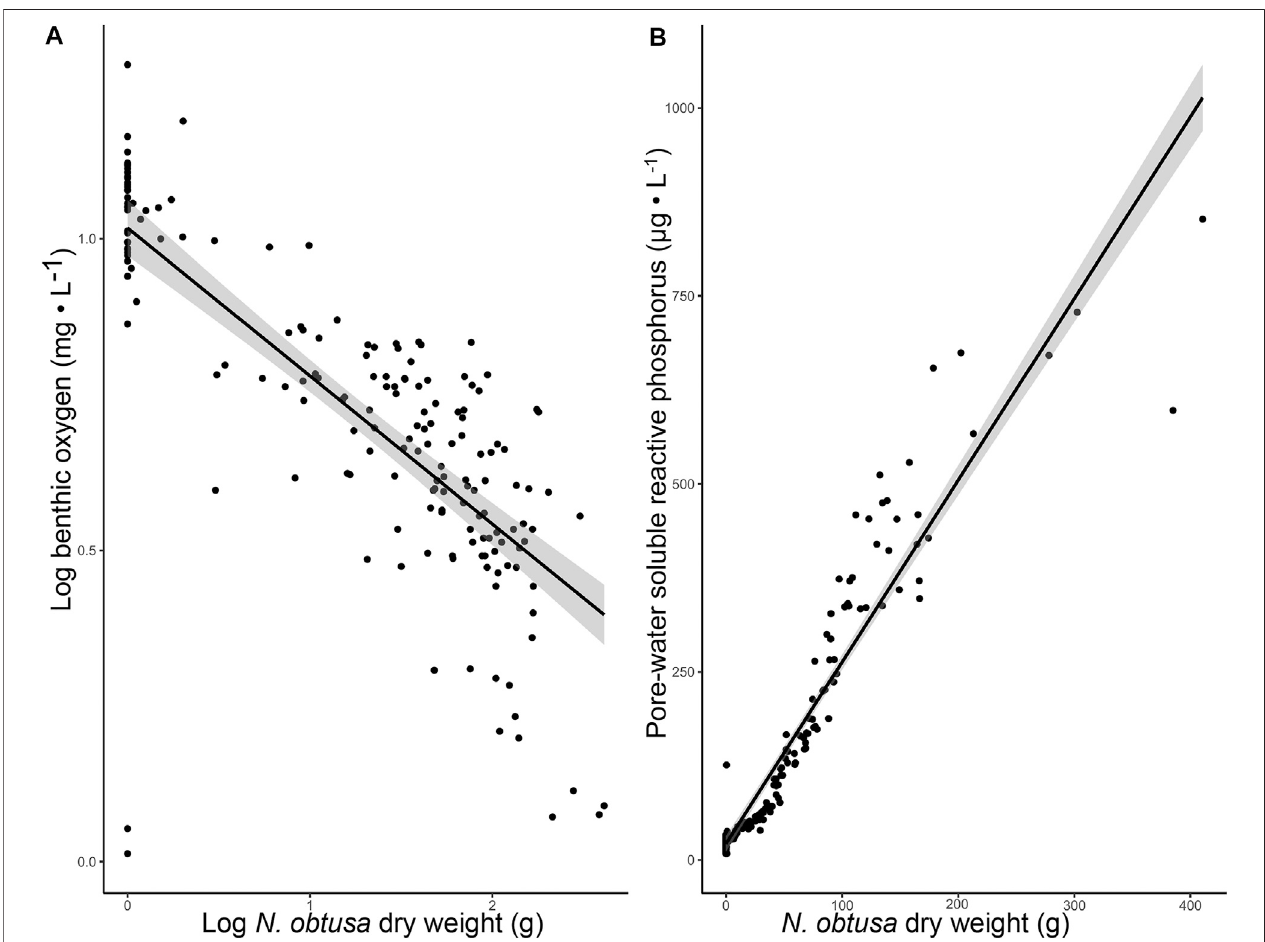
FIGURE 4 | (A) . Scatter plot with regression line visualizing the relationship between Log transformed benthic DO and N. obtusa dry-weight ( R 2 (cid:1) 0.59, p -value < 0.001) (B) . Scatter plot with regression line visualizing the relationship between pore-water SRP and N. obtusa dry-weight ( R 2 (cid:1) 0.90, p -value < 0.001).